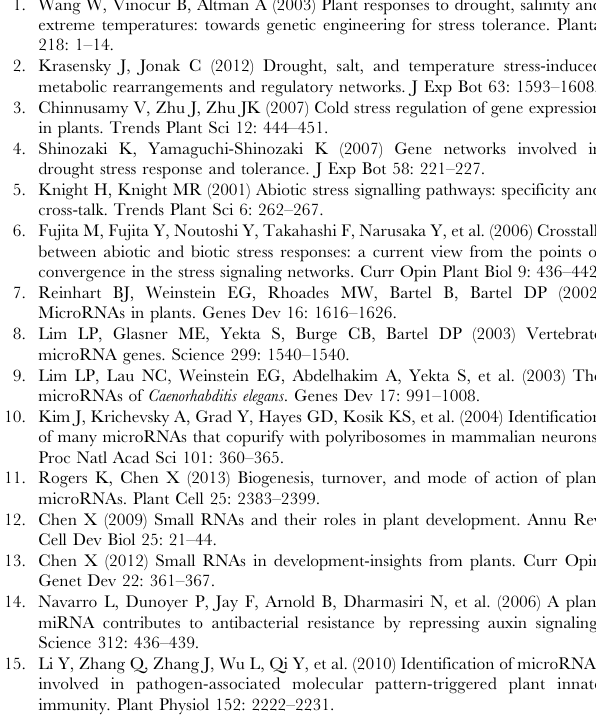
counts and fold change values in control and different Table S9 Precursor sequences of candidate novel miRNAs. Table S10 Putative targets of conserved miRNAs pre- dicted in B. rapa . Table S11 Putative targets of true novel and candidate novel miRNAs predicted in B. rapa . Table S12 Sequences and additional details of targets validated by 5 9 RLM-RACE. Table S13 Mapping summary of putative small RNA